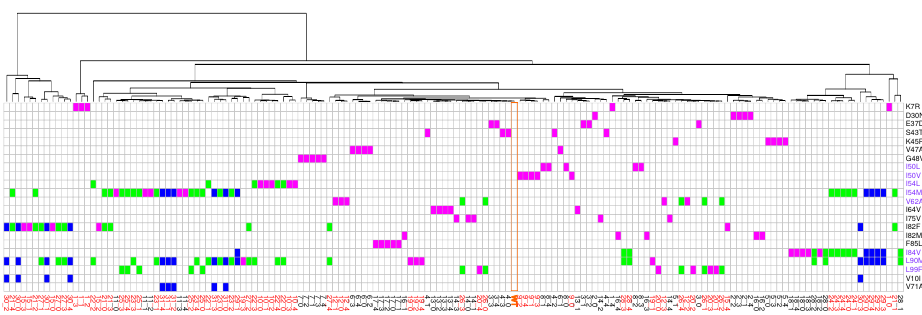
Figure 5. Hierarchical classification of wild-type and mutant pockets according to their conforma- tional similarity quantified by pairwise RMSD computing using all pocket atoms. The table provides the description of each mutant structure in terms of mutations. Mutant structures are ranked accord- ing to their apparition in the classification. Single mutants are colored in magenta, double mutants in green and triple mutants in blue. The orange column locate the wild-type pocket. Mutations colored in purple correspond to mutations located in the binding pocket and mutant colored in red contain a MCS atom located in the binding pocket.